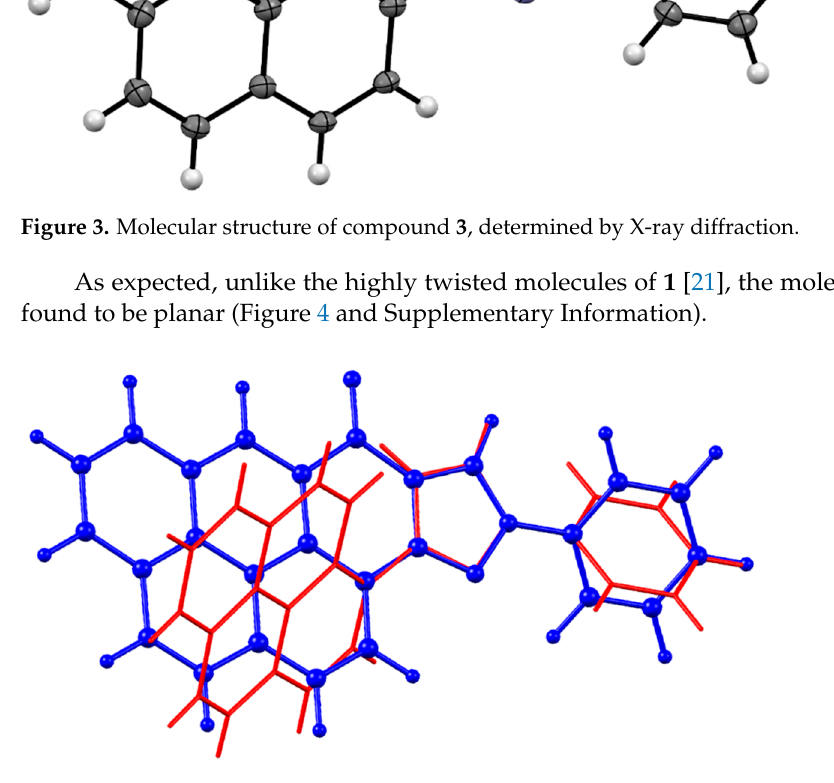
Figure 4. Overlay of the X-ray diffraction-derived structures of 3 (blue) and 1 (red).